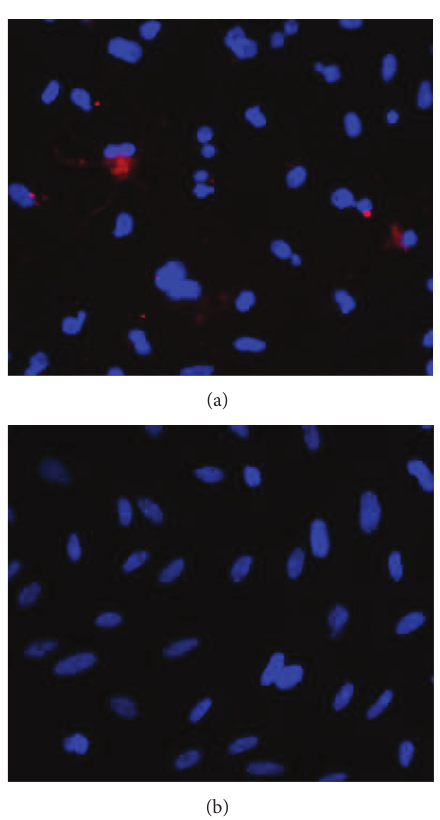
Figure 3: Positive control to the caspase-3 antibody. Cultured RPE cells were incubated with 1 𝜇 M staurosporine for 24 hours in order to trigger expression of caspase-3 and induce cell apoptosis. (a) Photomicrograph showing immunostaining of caspase-3 (red) in apoptotic cells treated with staurosporine. Nuclei were stained with DAPI (blue). Original magnification: × 200. (b) Negative control showing only DAPI staining (blue) when no staurosporine is added. Original magnification: ×